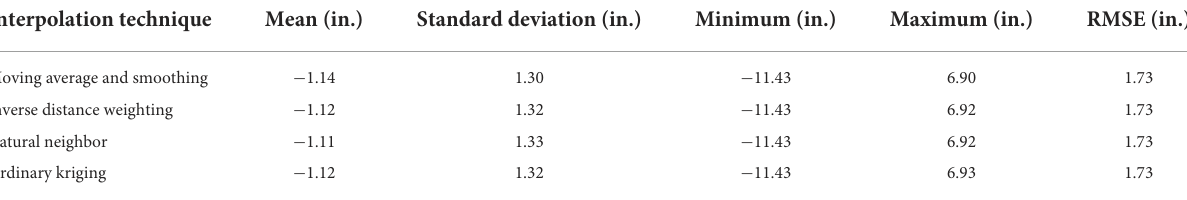
TABLE 6 Descriptive statistics and root-mean-square error for Risk MAP-modeled minus predicted 500-year D , for cells having only 500-year return period flood depth, for the Metairie, Louisiana, study area, by moving average (31 × 31) and smoothing (3 × 3), inverse distance weighting, natural neighbor, and ordinary